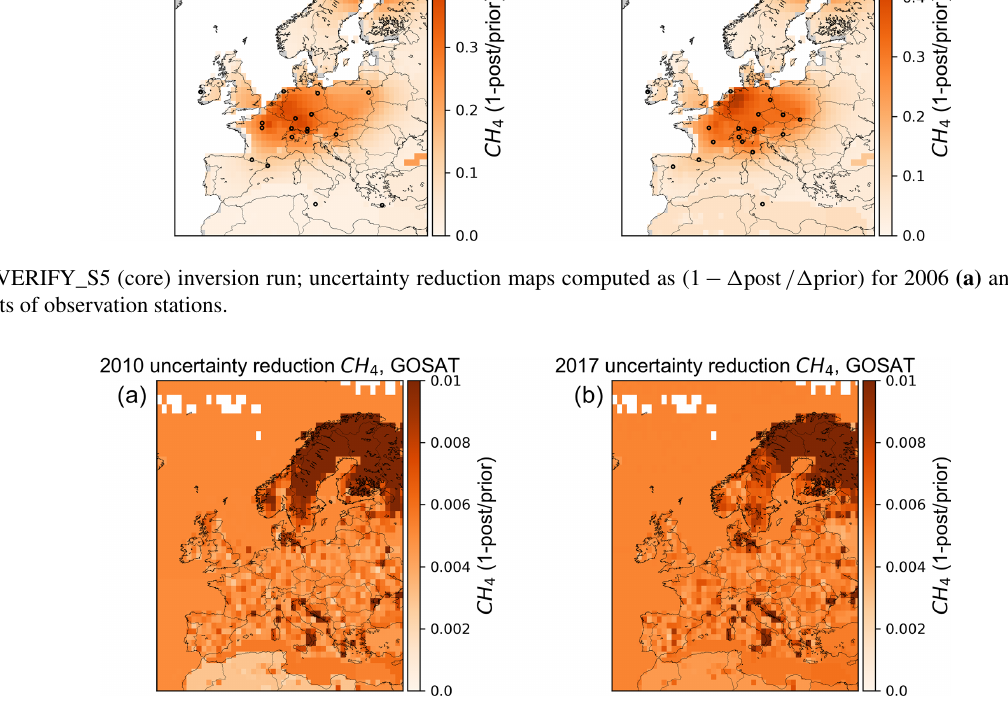
of 113 kt N 2 O yr − 1 (southern Europe), while the EU27 + UK total natural emission is estimated at 178 kt N 2 O yr − 1